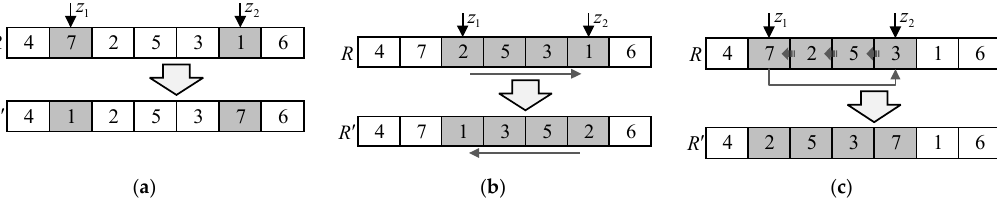
Figure 1. Schematic diagrams of three operations. ( a ) Mutation operation using randomly exchanging two genes of one chromosome; ( b ) Evolutionary reversal operation through re-sorting genes between two random gene positions; ( c ) Slide operation via rotating one gene position left between two random gene positions.